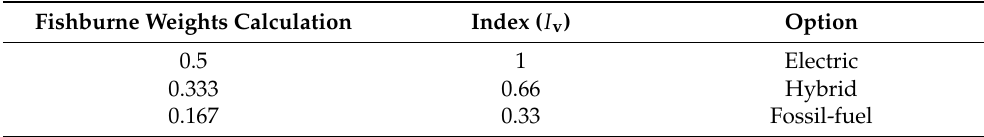
Table 25. Index system for the type of